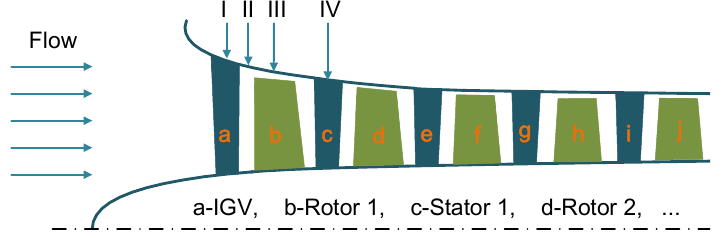
Figure 2. Diagram of noise measurement positions.